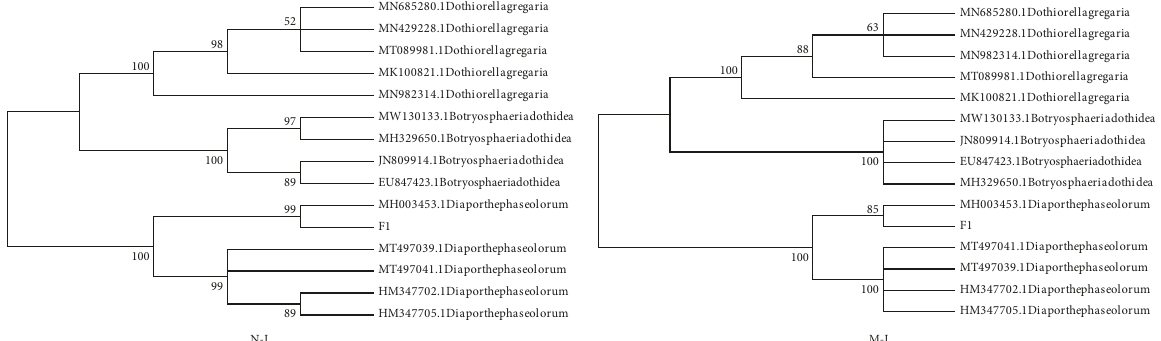
Figure 2: Phylogenetic trees of the ITS sequence of strain F1 constructed based on the N-J and M-L methods.